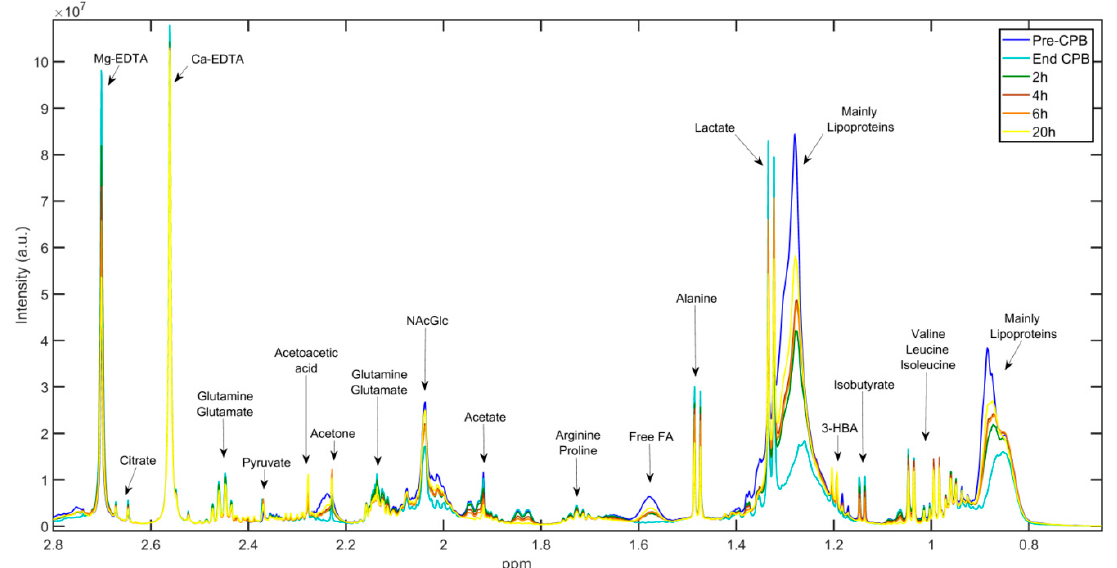
Figure 2. 600 MHz 1 H-NMR CPMG spectra of metabolite signals identified in plasma obtained from the standard group before and after CPB (pre-CPB, blue; end CPB, cyan; 2 hours post-CPB, green; 4 hours post-CPB, brown; 6 hours post-CPB, orange; 20 hours post-CPB, yellow). EDTA, Ethylenediaminetetraacetic acid; FA, fatty acid; 3-HBA, 3-hydroxybutyric acid; ppm, part per million; a.u., arbitrary units.